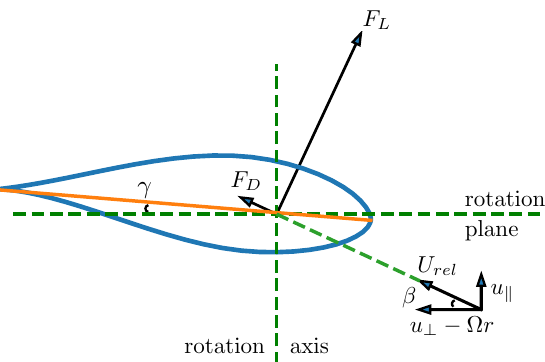
Figure 1. The estimation of aerodynamic lift force F L and drag force F D on an airfoil section. The upstream fluid velocity is decomposed into a parallel component u component u with respect to the rotation axis. The rotation speed is the product of the angular ⊥ velocity Ω and the distance r to rotation center. U rel is the relative velocity in coordinate system of the airfoil